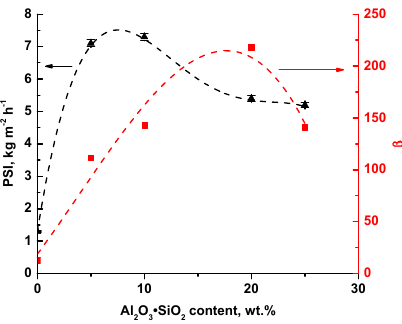
Figure 5. Dependence of PSI (black color) and separation factor ( β ) (red color) of PVA/PAN TFC membrane and PVA-Al 2 O 3 · SiO 2 /PAN TFN membranes on nanoparticle content in the selective layer.